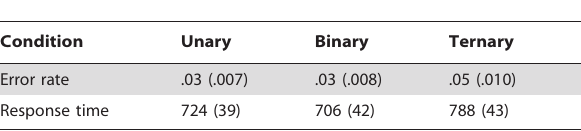
Table 1. Response by arity condition.